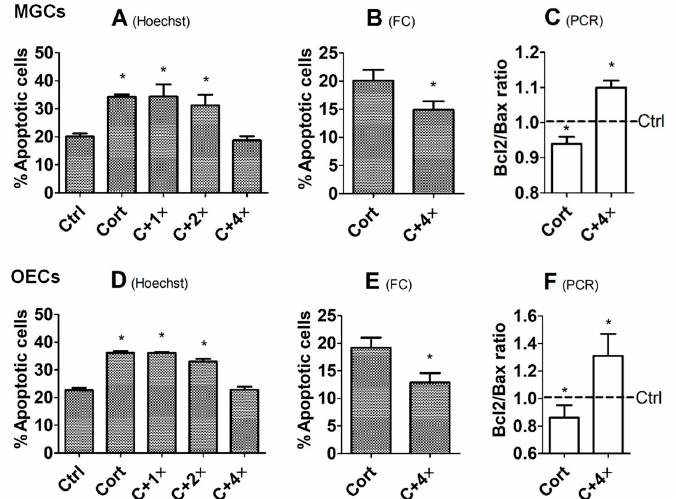
Figure 4. Effects of culture with tPA on corticosterone-induced apoptosis of mouse MGCs and OECs. While graphs ( A – C ) show percentages of apoptotic cells revealed by Hoechst staining or flow cytometry (FC) and the ratio of Bcl2/Bax measured by RT-PCR, respectively, in MGCs, graphs ( D – F ) show the same results in OECs. Each treatment was repeated 3 times, with each replicate including cells from 2 wells of a 6-well plate from 12 mice (MGCs) or from 2 wells of a 12-well plate from 4 mice (OECs). Ctrl, control; Cort, corticosterone (10 − 5 M); C + 1×, Cort + 1 × 10 − 8 M tPA; C + 2×, Cort + 2 × 10 − 8 M tPA; C + 4×, Cort + 4 × 10 − 8 M tPA. * Indicates significant difference ( p < 0.05) from Ctrl or Cort cells. In graphs ( B , E ), the percentages of apoptotic cells included both early and late apoptotic cells. In graphs ( C , F ), the ratio of Bcl2/Bax mRNA in Ctrl cells was set to one (dotted line) and the ratio in Cort or C + 4× treated cells was expressed relative to it.